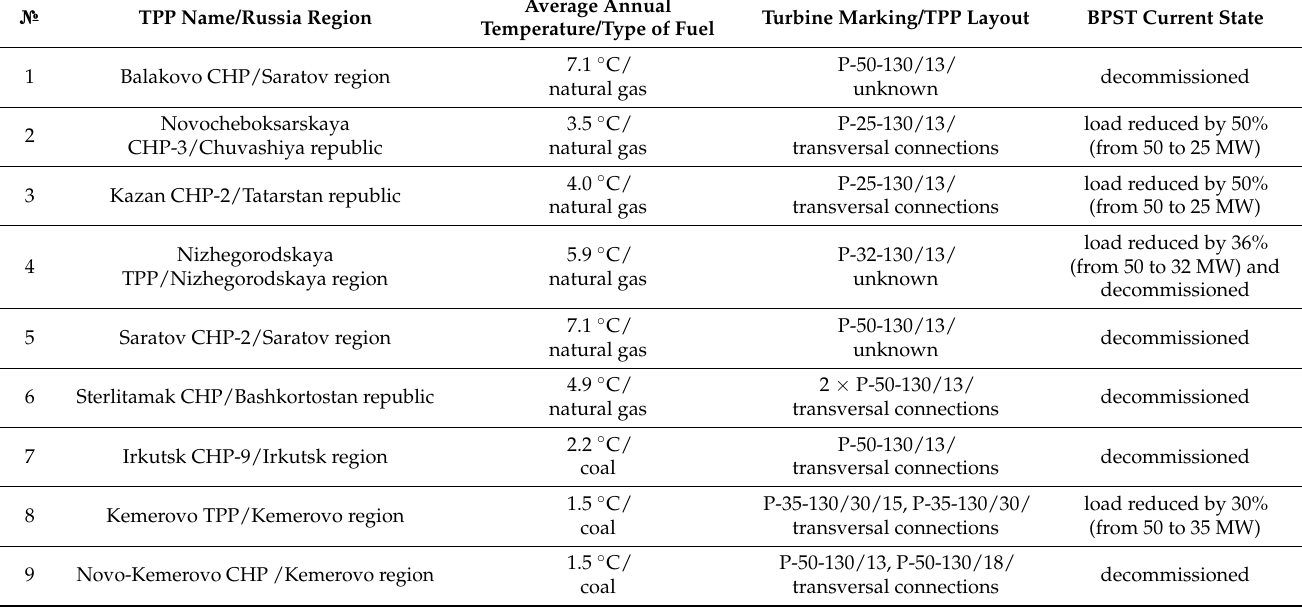
Table 1. Characteristics of TPPs with BPSTs operated with low load or decommissioned.